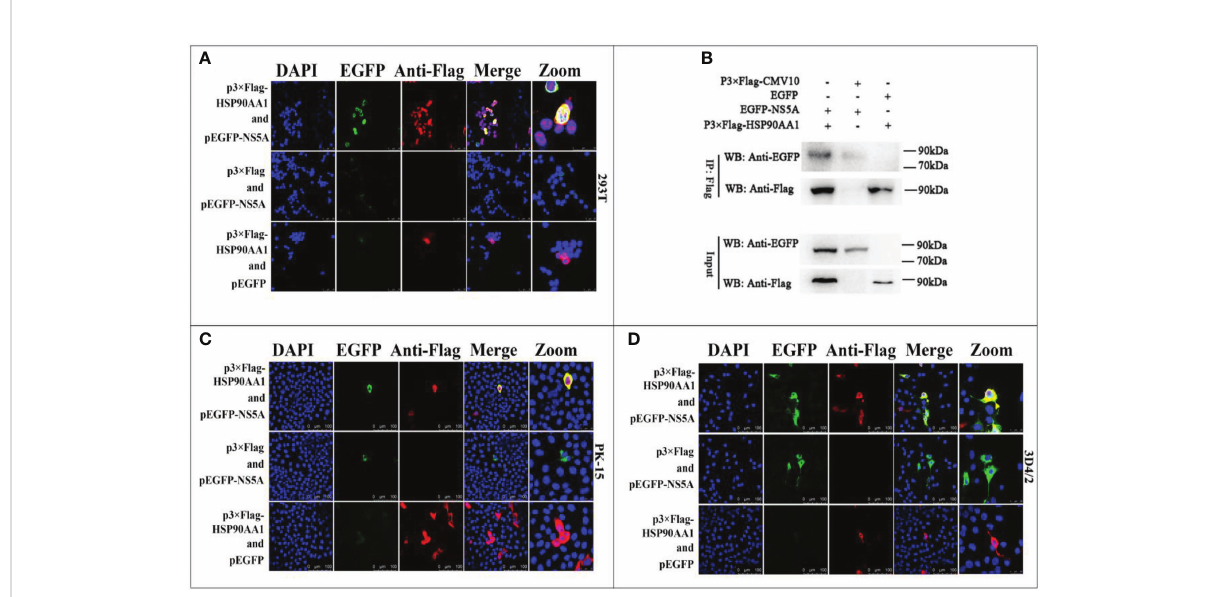
FIGURE 4 Validation for the interaction of HSP90AA1 with CSFV NS5A protein. (A) Identi fi cation of the colocalization of HSP90AA1 with NS5A protein in 293T cells. 293T cells co-expressing pEGFP-NS5A and p3×Flag-HSP90AA1 were analyzed by laser-scanning confocal microscopy. 293T Cells were co-transfected with pEGFP and p3×Flag-HSP90AA1 and pEGFP-NS5A with p3×Flag-CMV as negative controls. (B) Exogenous Co-IP analysis of NS5A with HSP90AA1 in 293T cells. 293T cells were co-transfected with p3×Flag-HSP90AA1 and EGFP-NS5A. 293T Cells were co- transfected with pEGFP and p3×Flag-HSP90AA1 and pEGFP-NS5A with p3×Flag-CMV as negative controls. (C, D) Identi fi cation of the colocalization of HSP90AA1 with NS5A protein in PK and 3D4/2 cells. PK-15 and 3D4/2 cells co-expressing pEGFP-NS5A and p3×Flag- HSP90AA1 were analyzed by laser-scanning confocal microscopy. PK-15 and 3D4/2 Cells were co-transfected with pEGFP and p3×Flag- HSP90AA1 and pEGFP-NS5A with p3×Flag-CMV as negative